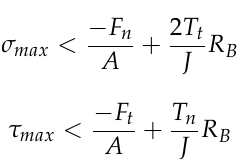
Figure 7. Particle bonding